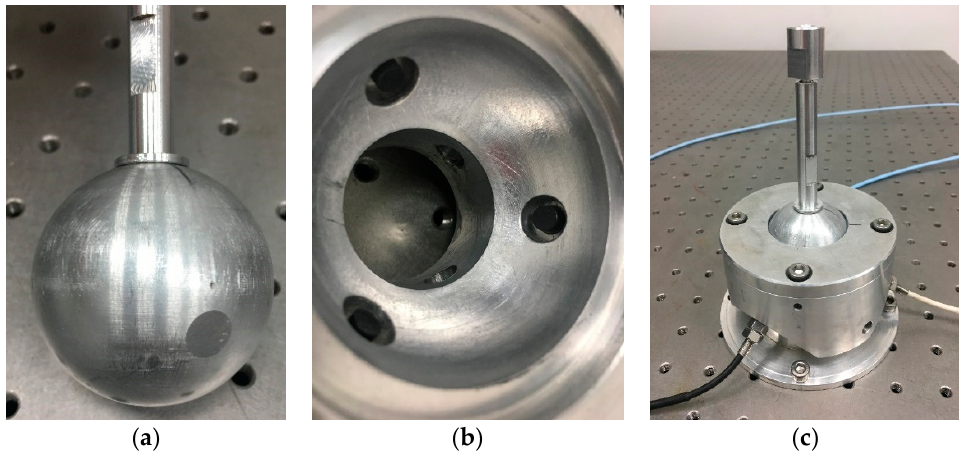
8 of 15 Figure 9. Small plane on the ball head. 4. Hardware and Software Algorithms 4.1. Eddy Current-Based Prototype The ball joint prototype based on eddy current sensors was manufactured and assembled on the basis of the analysis and measurement feasibility simulation results. As shown in Figure 10a, three small planes with diameters of 50 mm were milled on the ball head and uniformly distributed along